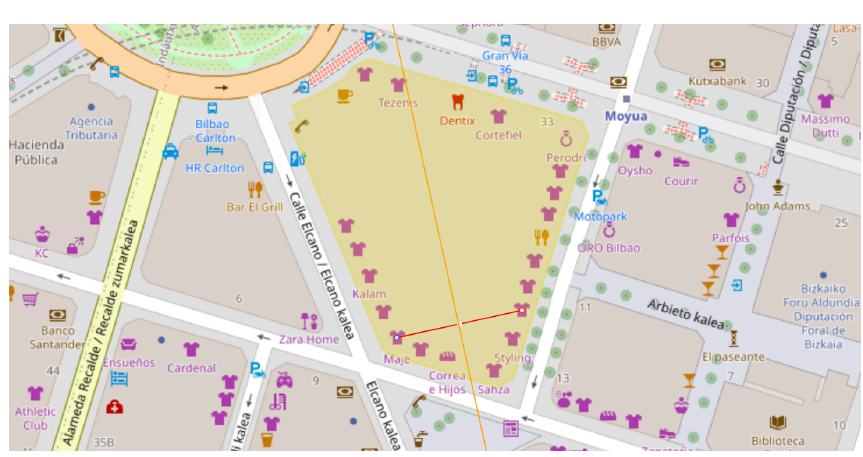
Figure 21. Limit B. 3. Points in non-consecutive edges . In this case, the dots are used instead of the projec- tions. We use the nearest neighbor in the red edge (see Figure 22).